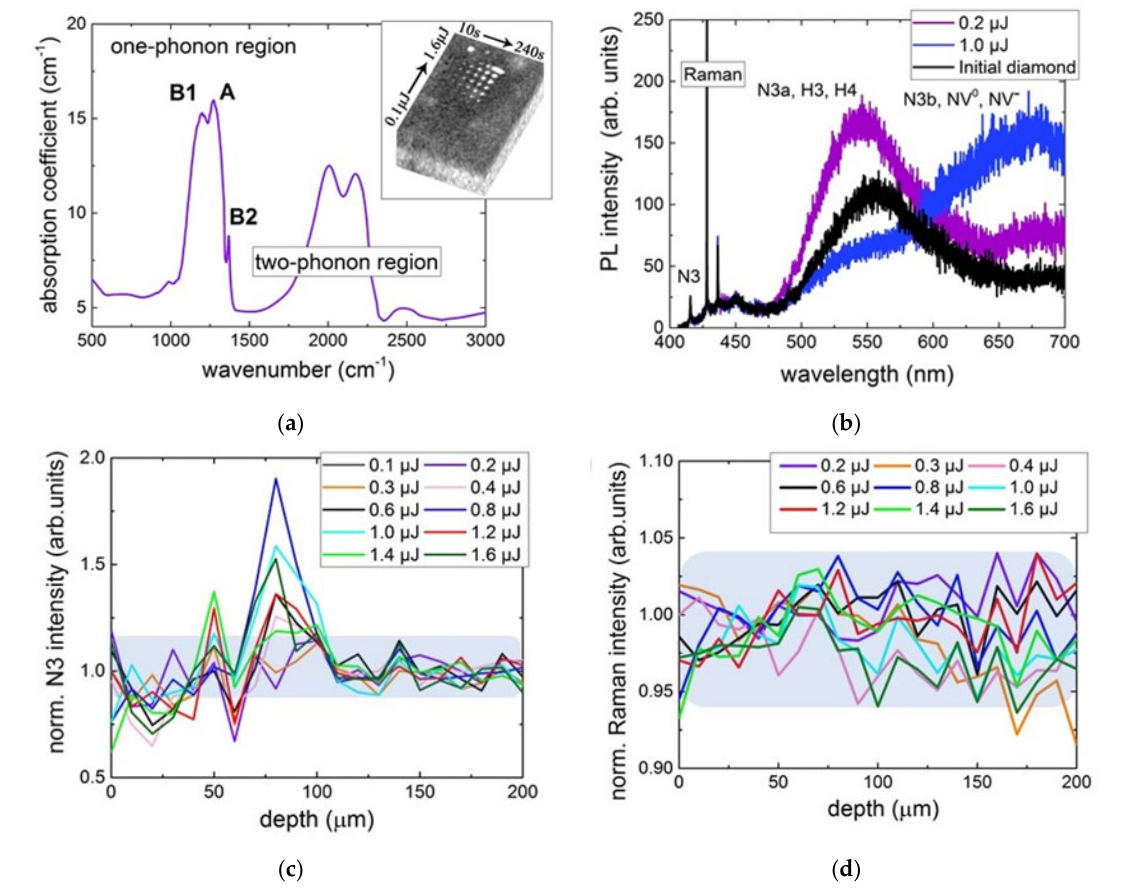
Figure 9. ( a ) FT ‐ IR spectrum of the initial diamond. Inset: Array of PL micromarks in IaAB diamond inscribed by 515 nm, 0.3 ps laser pulses at 0.25 ‐ NA focusing, variable energies and exposures (×100 kHz); ( b ) Raman and PL spectra of the unexposed and laser modified regions at the selected fs ‐ laser pulse energies of 0.2 and 1.0 μ J; ( c ) PL spectra of 415 nm N3 ZPL intensity of the unexposed and laser modified regions at different fs ‐ laser pulse energies in the range of 0.1–1.6 μ J; ( d ) depth dependence of 428 nm Raman line intensity of the unexposed and laser modified regions at different fs ‐ laser pulse energies in the range of 0.1–1.6 μ J.